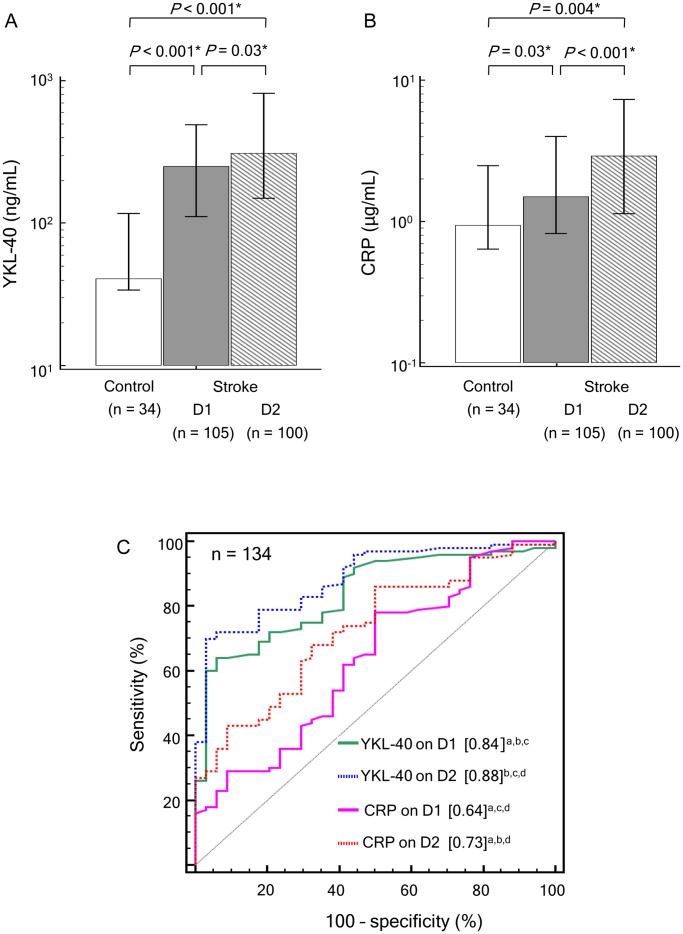
Levels of serum YKL-40 (A) and CRP (B) in acute ischemic stroke patients and controls.Each box indicates the median. Horizontal lines indicate the interquartile ranges. (C) Diagnostic accuracies of serum YKL-40 and CRP for discriminating acute ischemic stroke patients (n = 100; for statistical assessment of the differences between D1 and D2, 5 of 105 patients were excluded because they [n = 5] dropped out of the D2 test) from controls (n = 34) using receiver operating characteristic (ROC) curves. Numbers in square brackets indicate diagnostic accuracies (area under the ROC curves). D1, within 12 hours of symptom onset; D2, 18–24 hours from baseline (D1); CRP, C-reactive protein. *P<0.05. a
P<0.05, vs. YKL-40 on D2. b
P<0.05, vs. CRP on D1. c
P<0.05, vs. CRP on D2. d
P<0.05, vs. YKL-40 on D1.